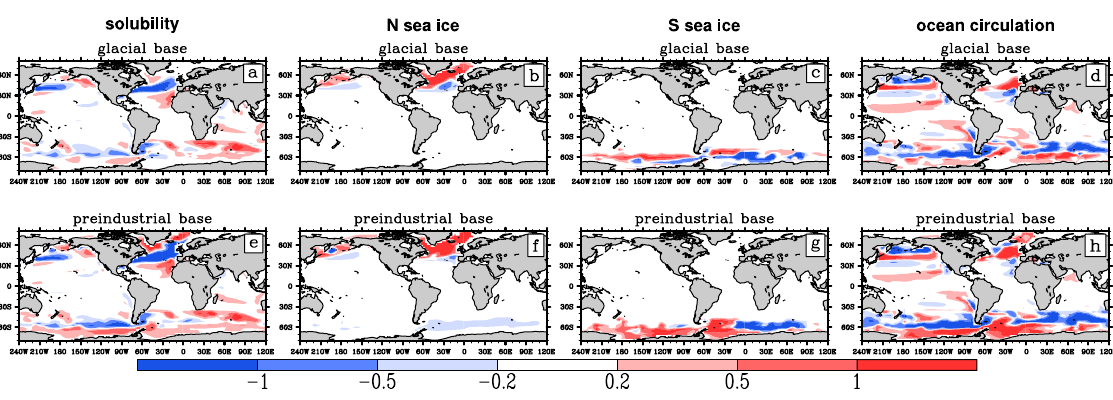
Fig. 11. Anomalous air-sea CO 2 flux (molm − 2 yr − 1 ) due to changes in the solubility, sea ice in the Northern and Southern Hemispheres, and ocean circulation of LGb. Upper and lower panels are as in Fig.